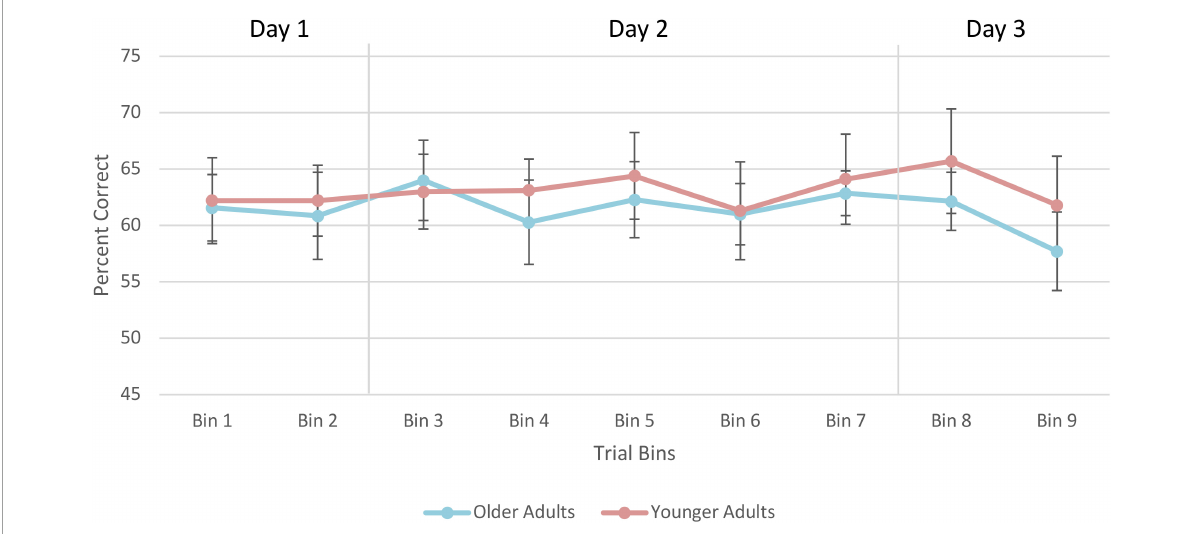
FIGURE10 Average percent correct on the training trials for older and younger adults. Values for each bin represent the average percent correct for each 100 trials. Error bars represent standard error. Participants completed 250 trials on Day 1, 400 trials on Day 2, and 250 trials on Day 3. Older adult data are plotted in blue, and younger adult data in